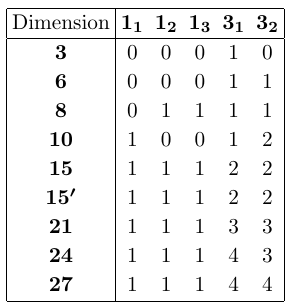
Table 25 . SU(3) ! T 7 . Table 26 . SU(3) ! (cid:1)(27).